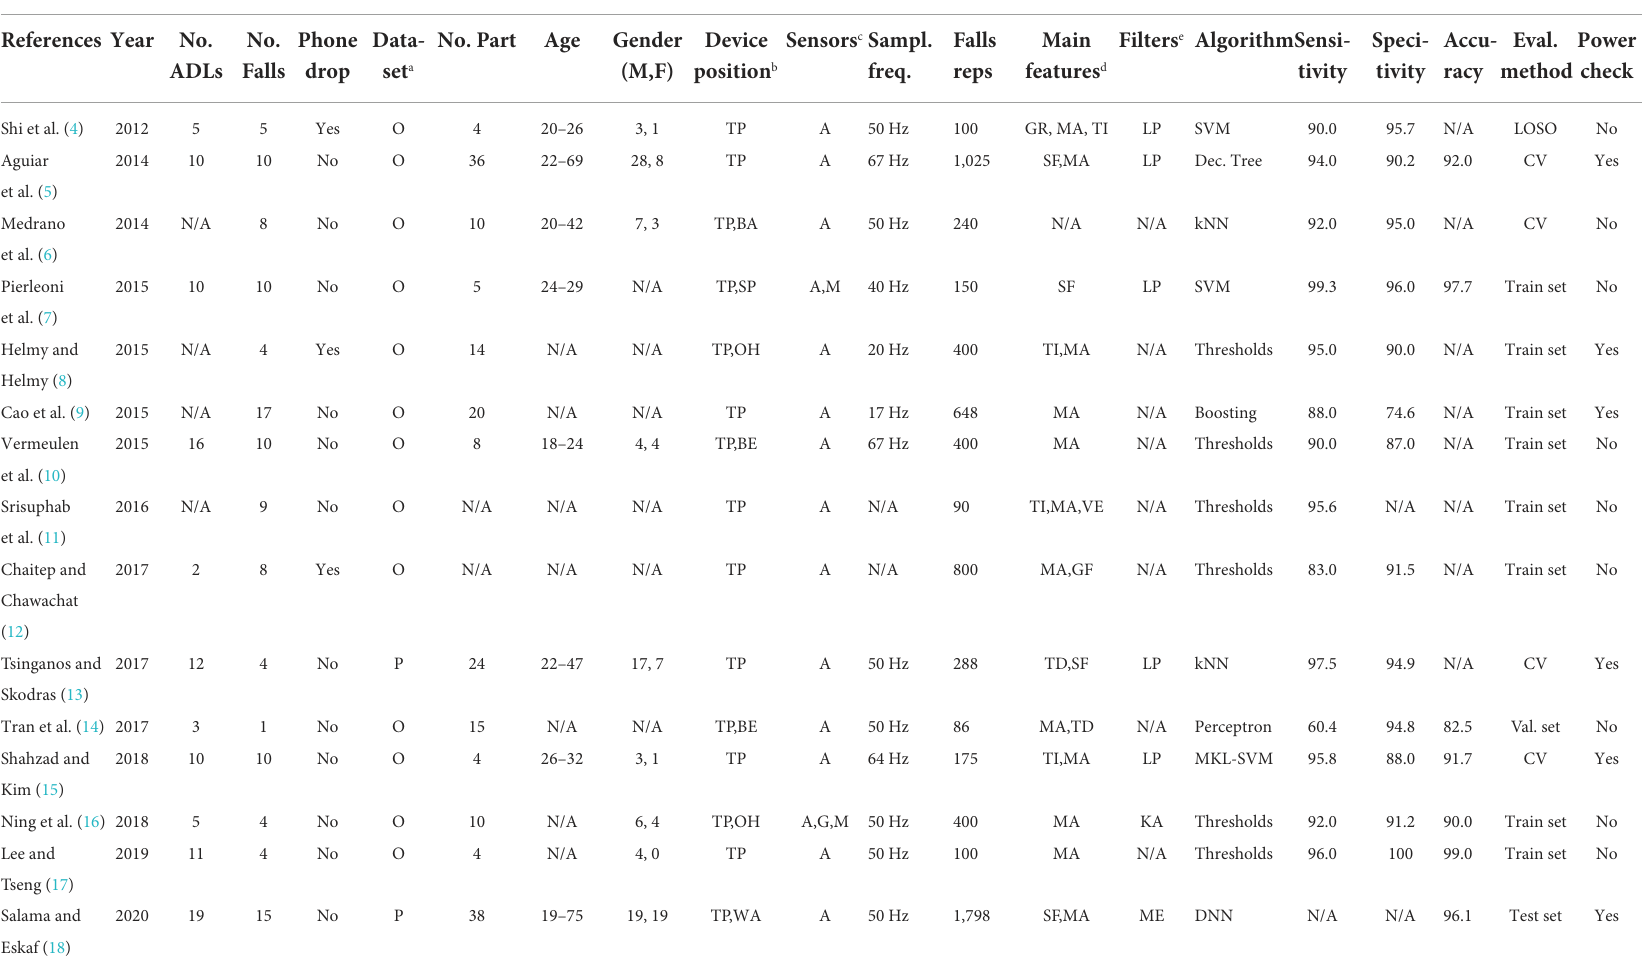
TABLE 1 Summary table of the 15 selected